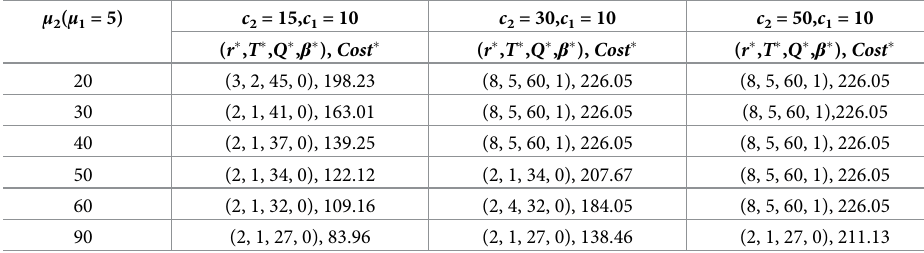
Table 5. Comparison of the relative arrival rate of order and the relative order price.